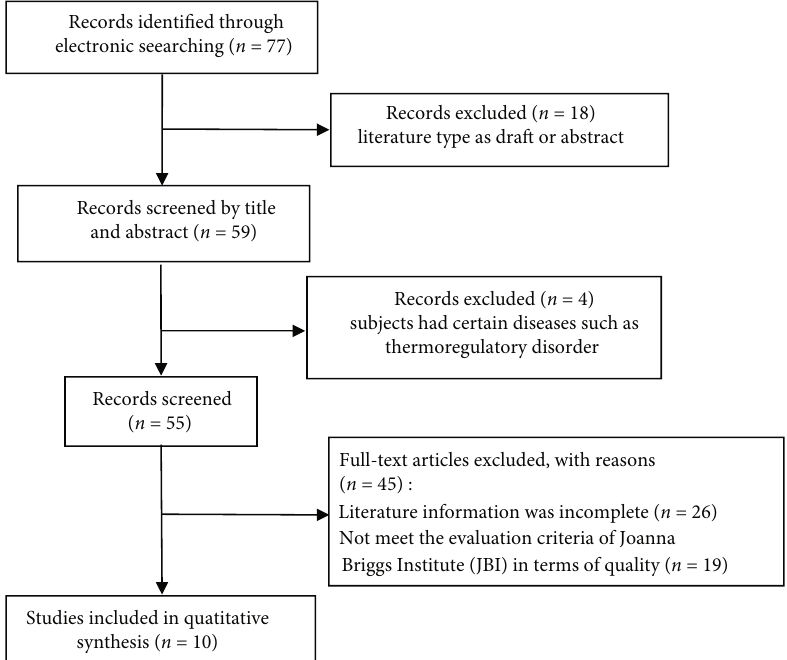
Figure 1: Flow chart of literature